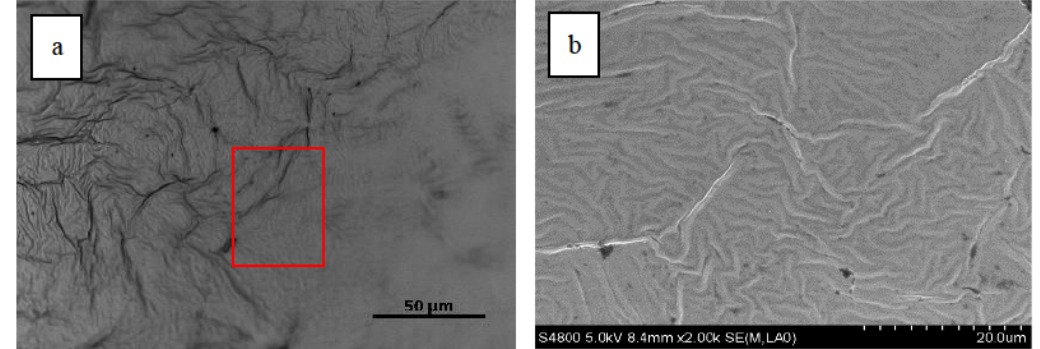
Figure 6: Surface morphology of the eutectoid microstructure generated after 30 pulses (a) low magnification; (b) high magnification